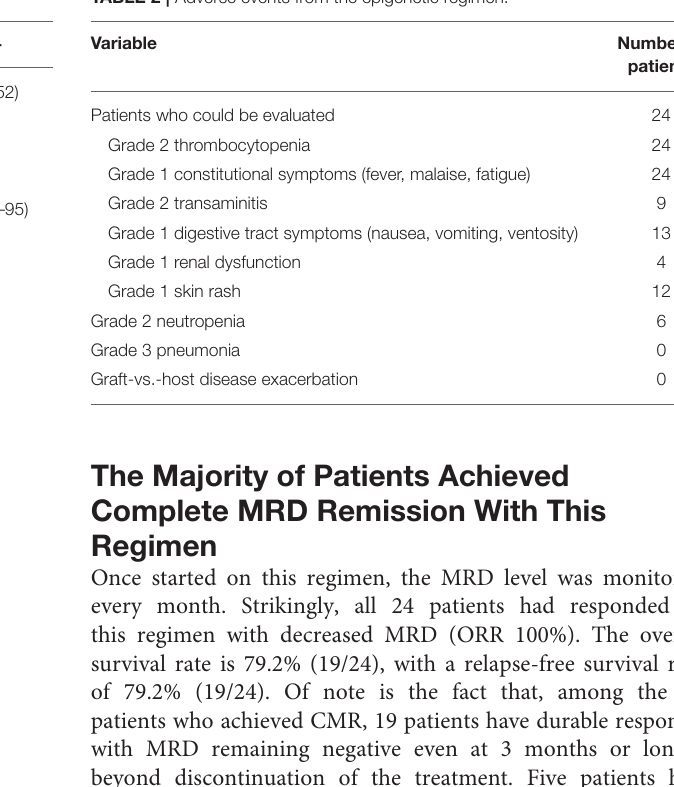
TABLE 1 | Characteristics of patients and donors. TABLE 2 | Adverse events from the epigenetic